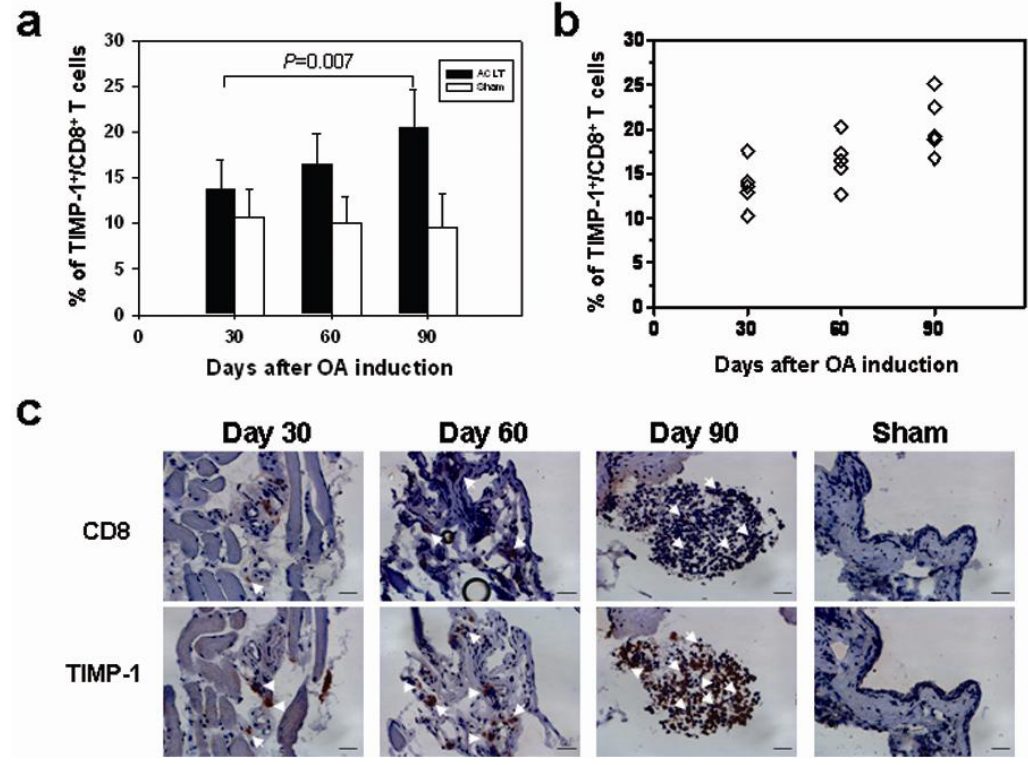
Figure 5. Increase of TIMP-1-expressing CD8 + T cells along with OA progression. ( a ) The percentage of TIMP-1-expressing CD8 + T cells in spleens was determined by flow cytometry ( n = 5 in each group). Data are means ± 95% confidence intervals. The disease severity was classified by three time points (30, 60 and 90 days) after OA induction; ( b ) Spearman’s correlation was used to determine the correlation between the percentage of TIMP-1-expressing CD8 + T cells, and the severity of OA, p = 0.0011; and ( c ) Synovial membrane from the Sham and ACLT groups on day 30, 60 and 90 were removed and stained with antibodies against CD8 + and TIMP-1. The Sham group on day 90 was shown. In the ACLT group mice, increased TIMP-1-expressing CD8 + T cell infiltration was seen in joints compared to that in the Sham group 90 days post-surgery (400× magnification; scale bar = 20 µm). The CD8- and TIMP-1-double positive cells were indicted with white arrows. The TIMP-1-positive cells were indicated with arrow